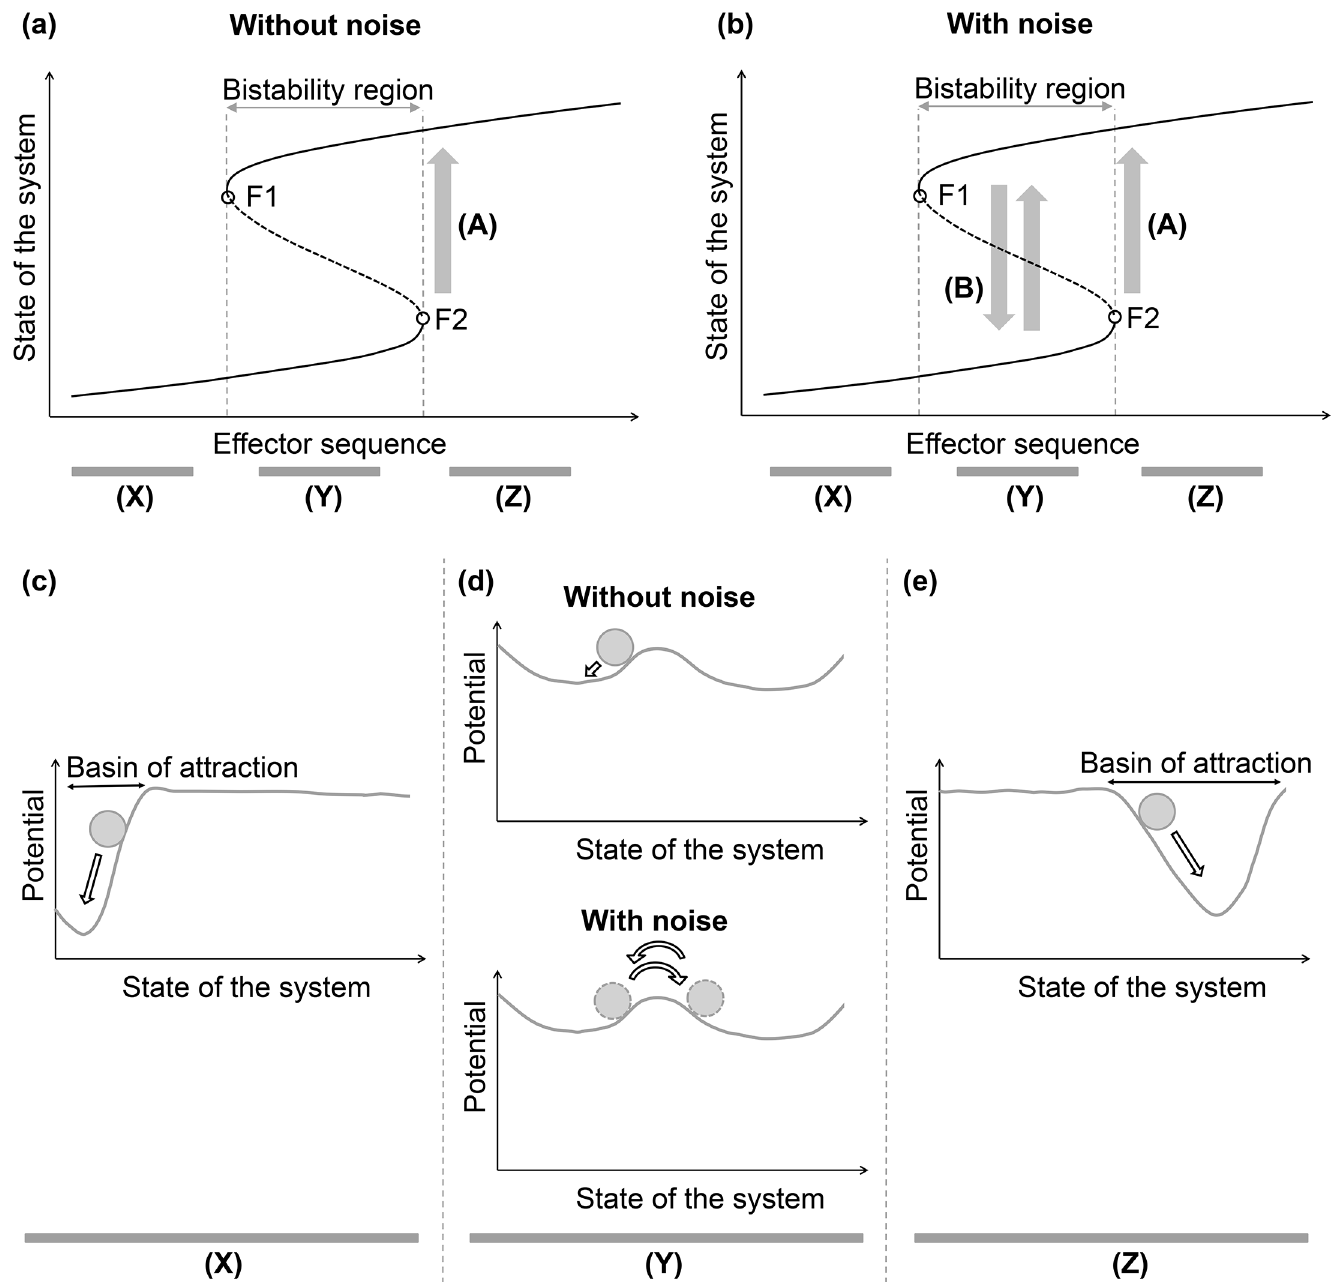
Fig 1. Flickering state transition before a critical transition in attractor dynamics. (a) and (b) represent critical transitions without and with noise in the attractor dynamics, respectively. The x-axis represents the effector sequence, and the y-axis denotes the state of the system. A solid line indicates an attractor, and the dotted line between the two solid lines represents an unstable state. A critical transition to an alternative attractor state (A) occurs at a bifurcation point (F1 or F2). Effectors in (a) and (b) are factors changing the attractor landscape. (c), (d), and (e) indicate the attractor landscapes reflecting the stability properties of the system in the region of (X), (Y), and (Z), respectively. Because a potential on the y-axis is inversely related to the steady state probability of its state, the dynamics tends to converge to a state with lower potential. A ball (grey circle) represents the current state and its potential. (d) In the region of (Y), the ball jumps back and forth between alternative basins of attraction from the impact of noise, namely the flickering state transition ((B) in Fig 1(b)). Such a flickering state transition increases the variation in the estimate of the basin sizes (the sizes of the basin of attraction) for the attractors.